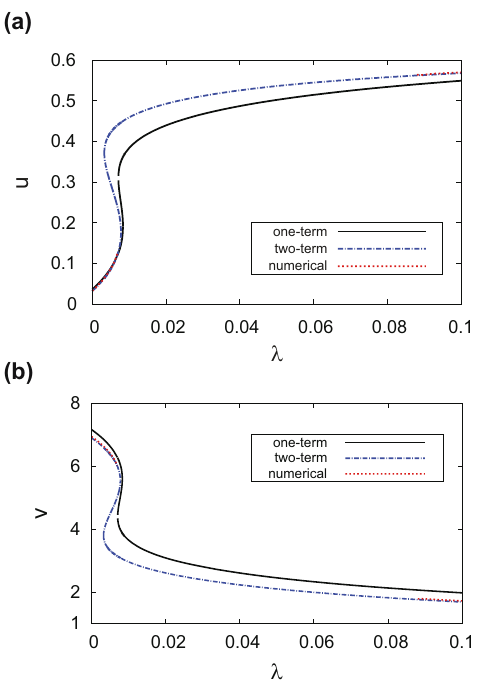
Figure 3: The breaking wave pattern of steady state bifurcation diagrams for ( a ) autocatalyst u and ( b ) reactant v concentra - tions, respectively, against the bifurcation parameter λ , at x 0 = . In these graphs, D 0.1 u = , D 0.05 v = , and all the other parameters are given in Figure 2.